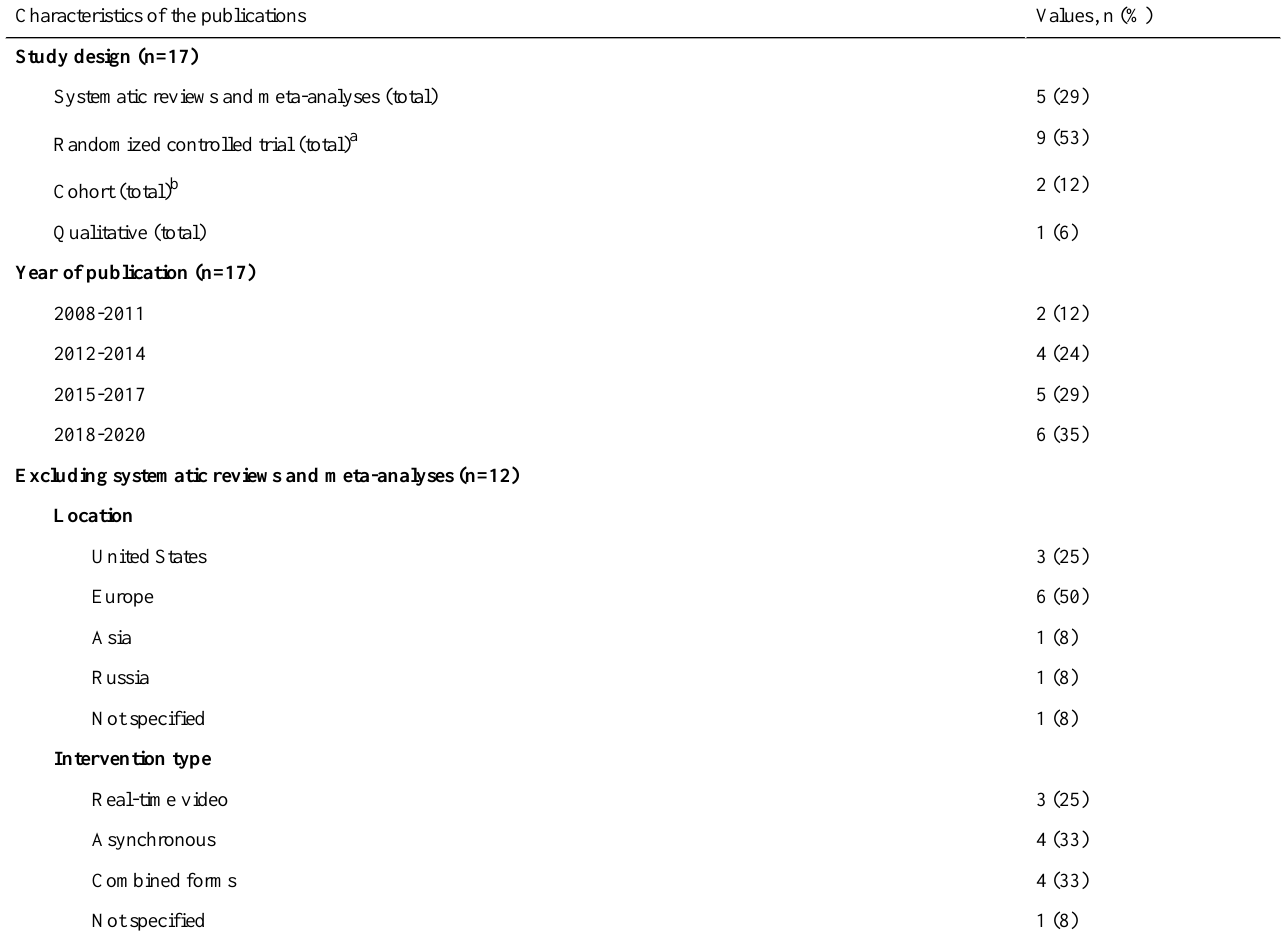
Table 1. Baseline characteristics of all the included publications.